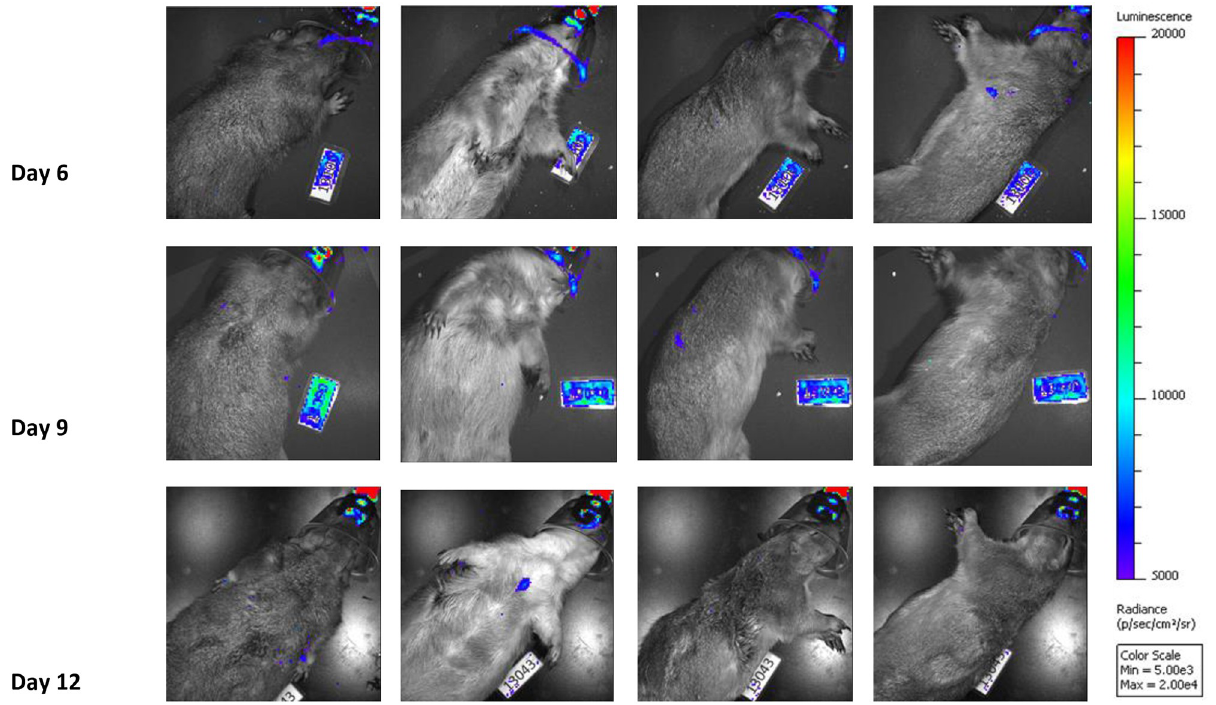
Fig 3. Time course of Prairie dogs infected with WT MPXV. Representative Prairie dogs infected with WT MPXV and imaged on indicated days Images are black and white photograph of a representative prairie dog taken at each time point overlaid with a false color representation of photon emission intensity as indicated by the scale on the right in ps -1 cm -2 sr -1 .